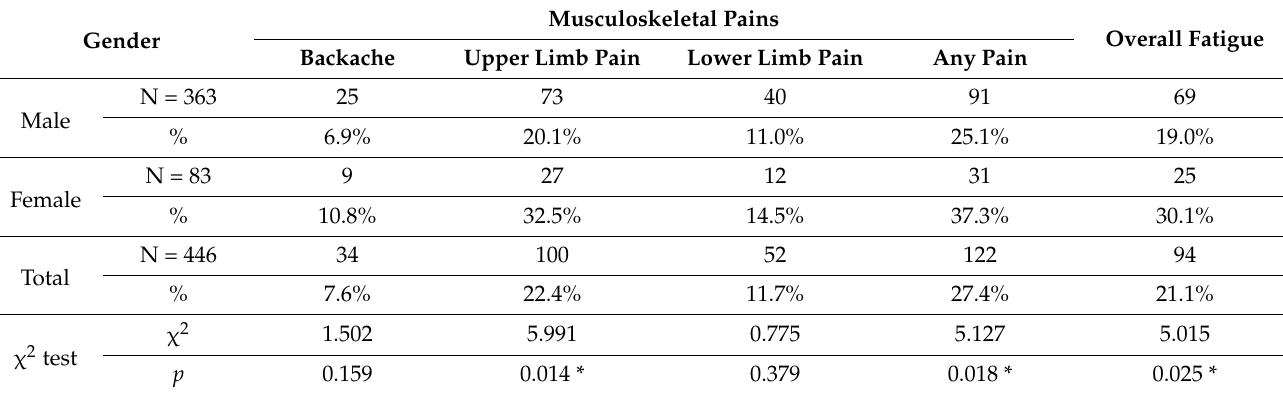
Table 4. Distribution of subjective musculoskeletal pains and overall fatigue by